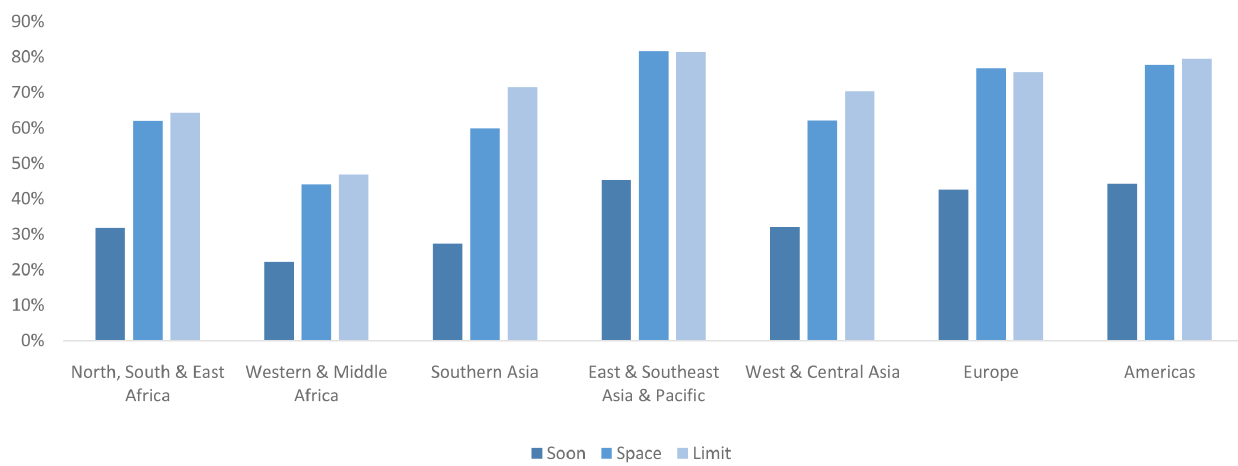
Figure 7. CPR by region for married market segments in 2040. This graph shows the contraceptive prevalence rate (CPR) among each of the three married segments (women waiting a child soon, women wanting to space, and women wanting no more children (limit)) by region. While there is some regional variation in pattern, in general women wanting a child soon are using at about half the level as the other two